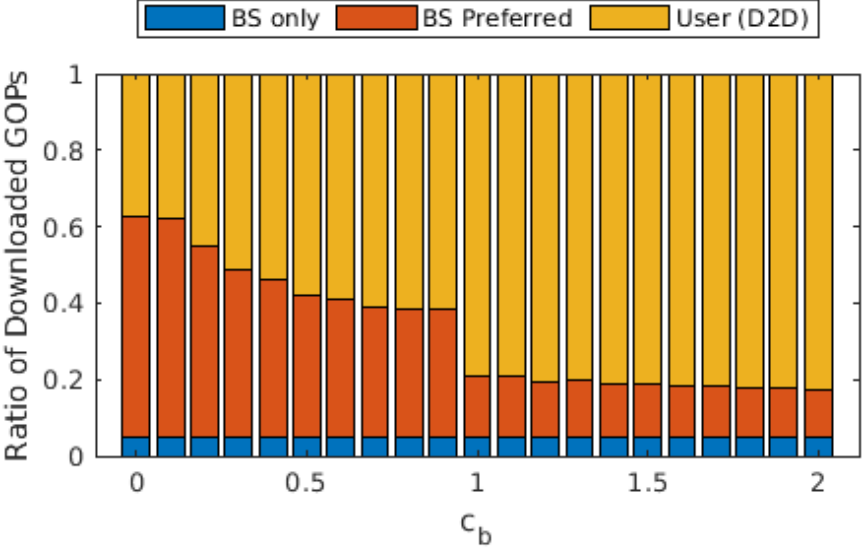
Figure 10. Ratio of the GOPs downloaded from the cloud/base station and GOPs downloaded from other users for different values of c b when transcoding is